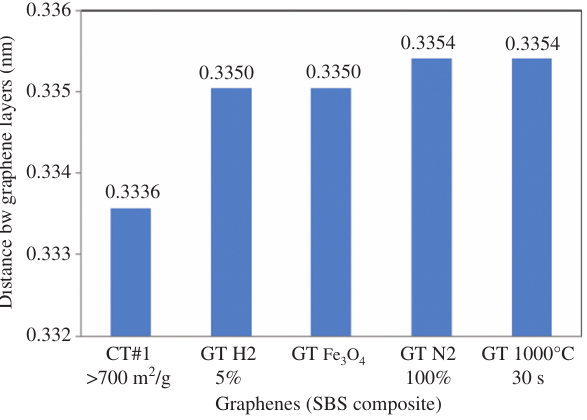
Figure 8 Graphenes (in SBS) versus distance between graphene